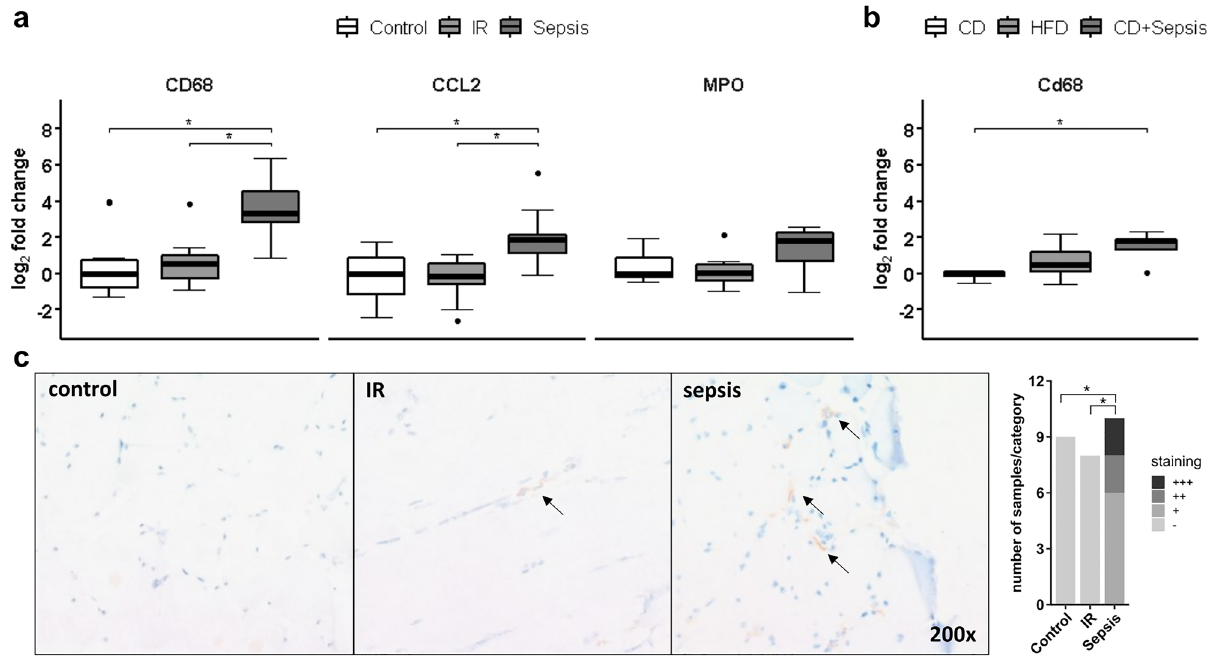
Figure 1. Markers of inflammation in skeletal muscle. Gene expression of inflammatory markers was assessed by RTqPCR in human ( a ) and murine ( b ) skeletal muscle. Data are given as normalized log 2 -fold changes compared to the median of the respective control groups as reference. Plots for human data represent n = 10 of matched subjects per group (for characterization see Suppl. Table 2), and plots for animal data represent n = 5–6 animals per group. Representative staining and semiquantitative assessment of CD68 in muscle tissue of patients ( c ) shows differences in number of macrophages (*p < 0.05, χ 2 -test). Arrows indicate exemplary CD68 positive cells (brownish coloring). CD control diet, CD/Cd68 cluster of differentiation 68, HFD high-fat diet, CCL chemokine C–C motif ligand, IR insulin resistance, MPO myeloperoxidase, RTqPCR quantitative real-time PCR, *p <